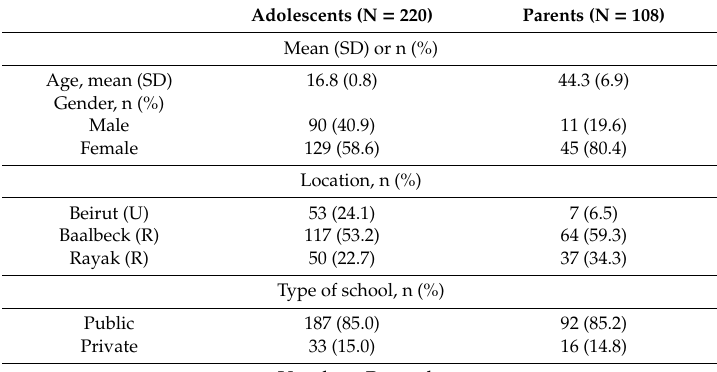
Table 3. Demographic characteristics of the